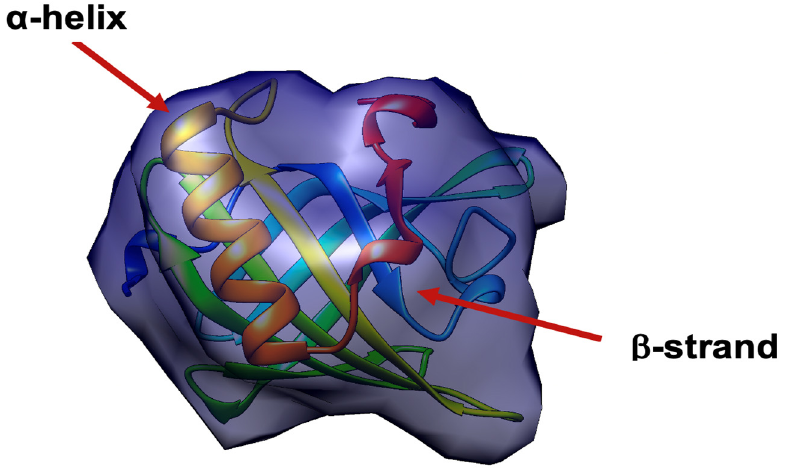
Figure 2. Secondary structure elements ( α -helices and β -strands) in the fitted atomic structure with cryo-EM map visualized by Chimera [29].